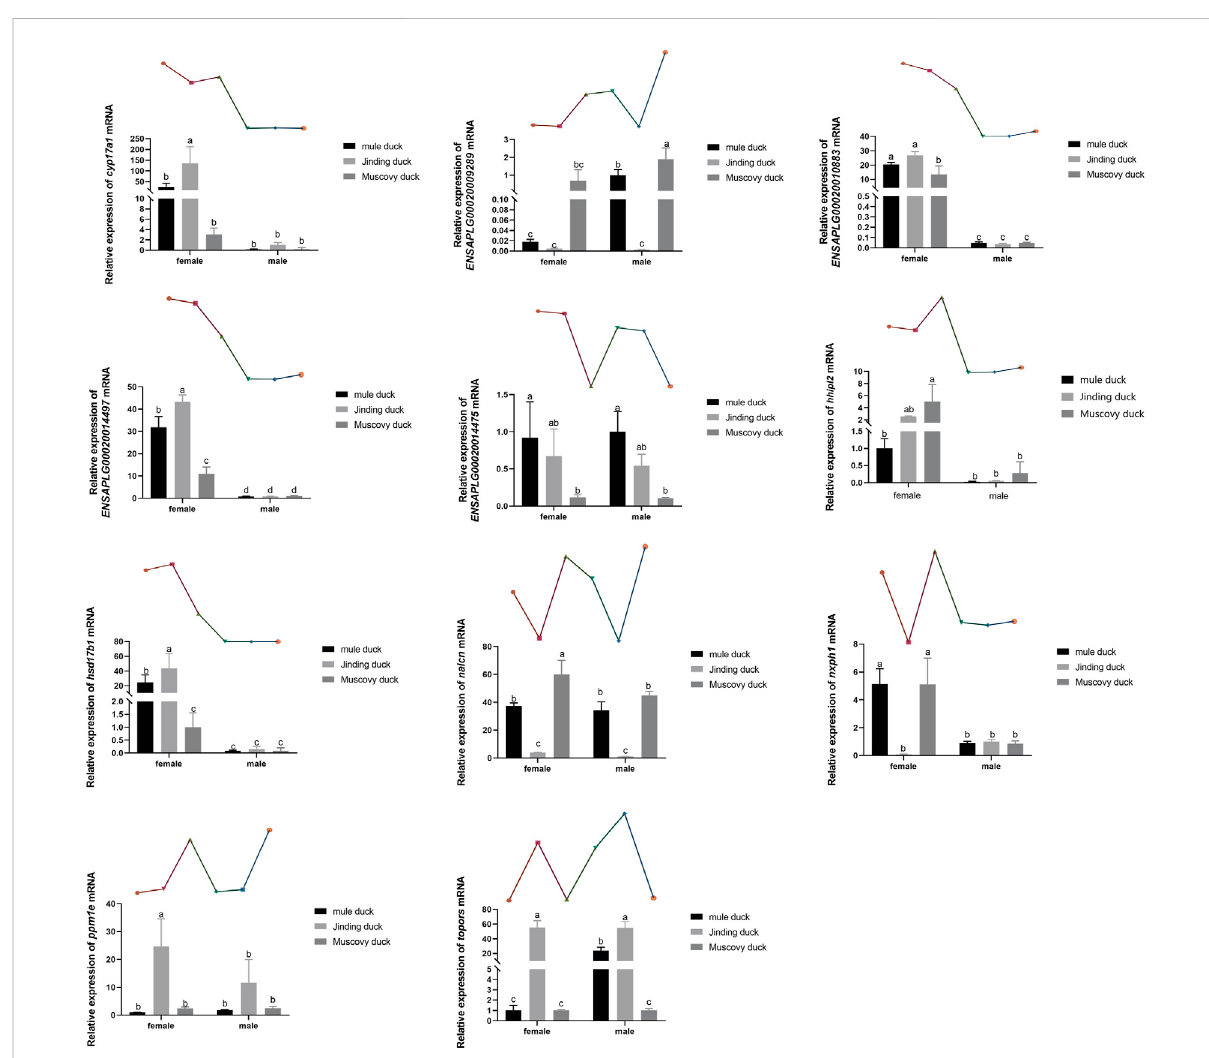
FIGURE 6 qRT-PCRvalidationof11DEGsidenti fi